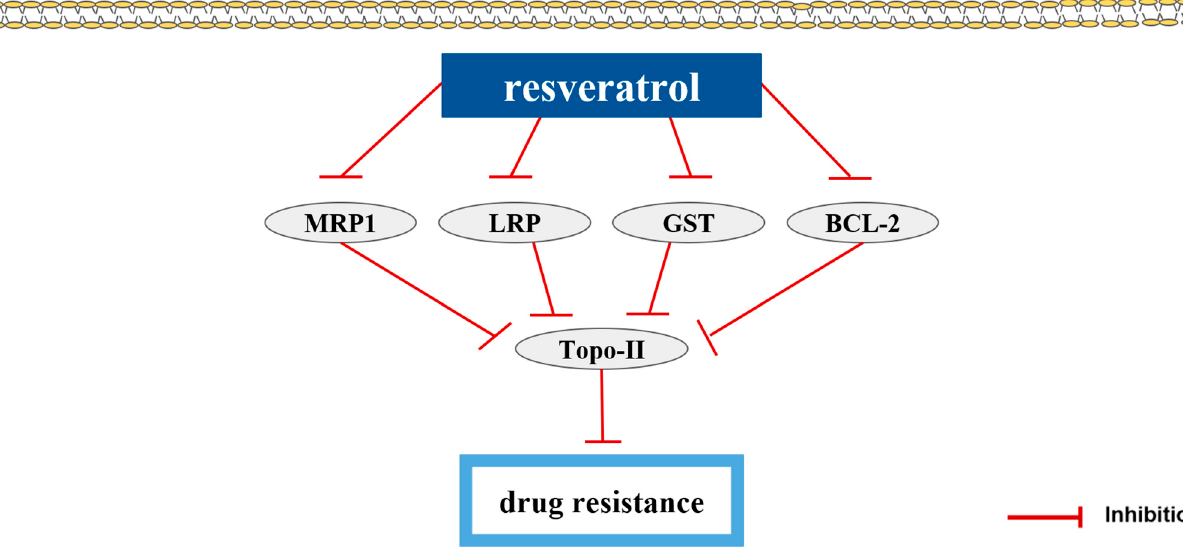
Figure 8. Natural products and drug resistance. Topo-II suppresses drug resistance. RES decreases MRP1, LRP, GST, BCL-2 expression levels. By the law of total mass conservation, Topo-II levels are increased. As a result, RES inactivates drug resistance. Abbreviation: BCL-2, B-cell leukemia/lymphoma 2; LRP, lung resistance protein; MRP1, multi-drug resistance 1; Topo-II, topoisomerase II; GST, glutathione S-transferase.